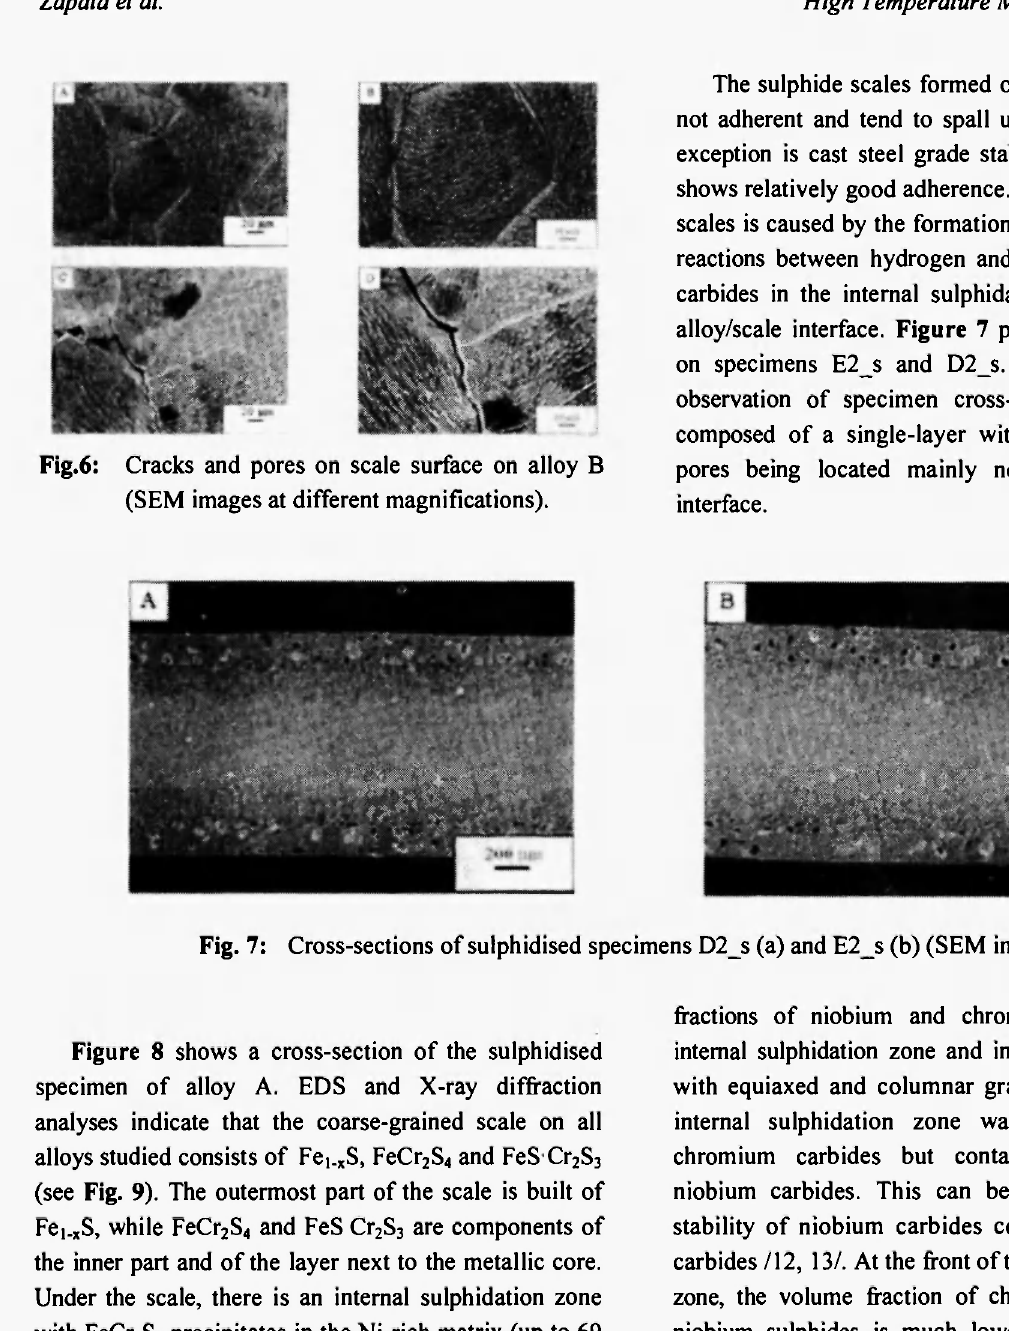
Fig.6: Cracks and pores on scale surface on alloy Β (SEM images at different magnifications).